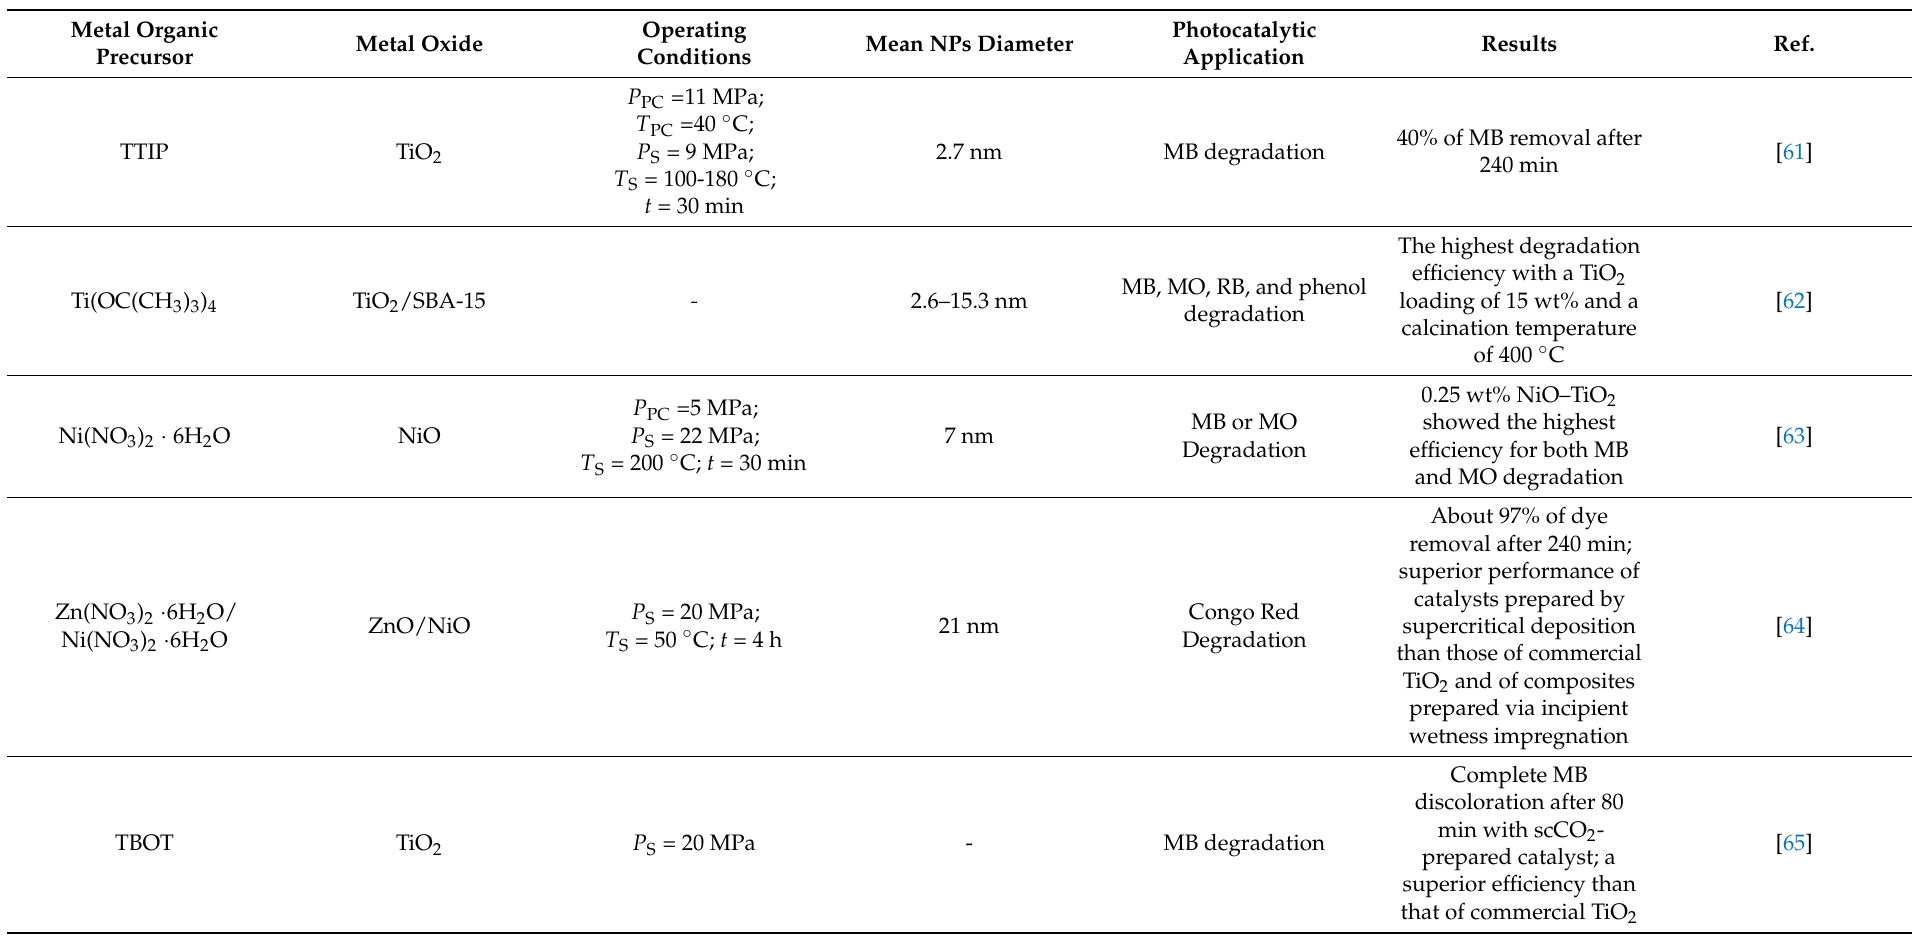
Table 1. Synthesis of photocatalysts by supercritical deposition. NPs = nanoparticles; MB = methylene blue; MO = methyl orange; RB = rhodamine B; TBOT= tetrabutyl orthotitanate;